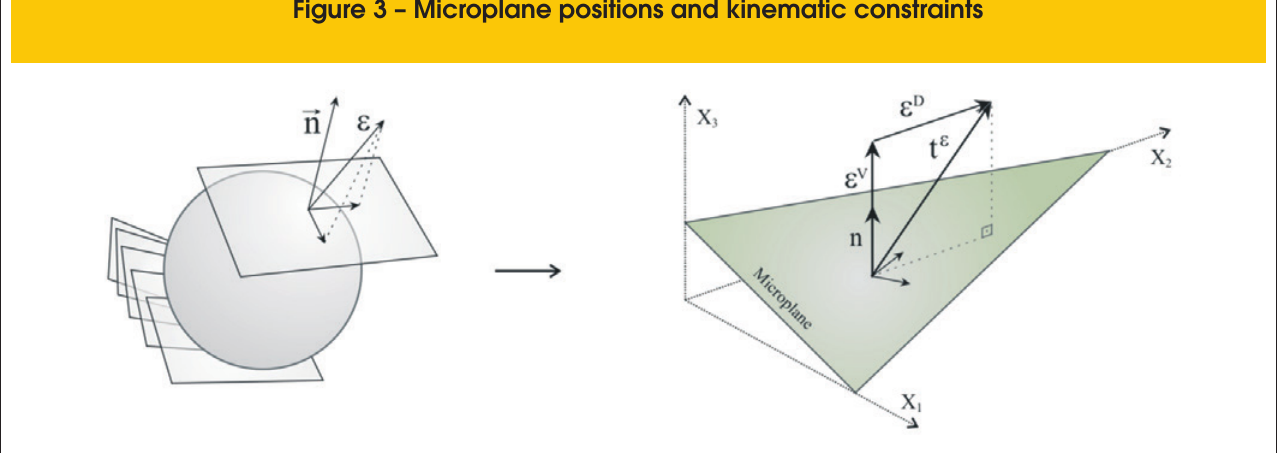
Figure 3 – Microplane positions and kinematic